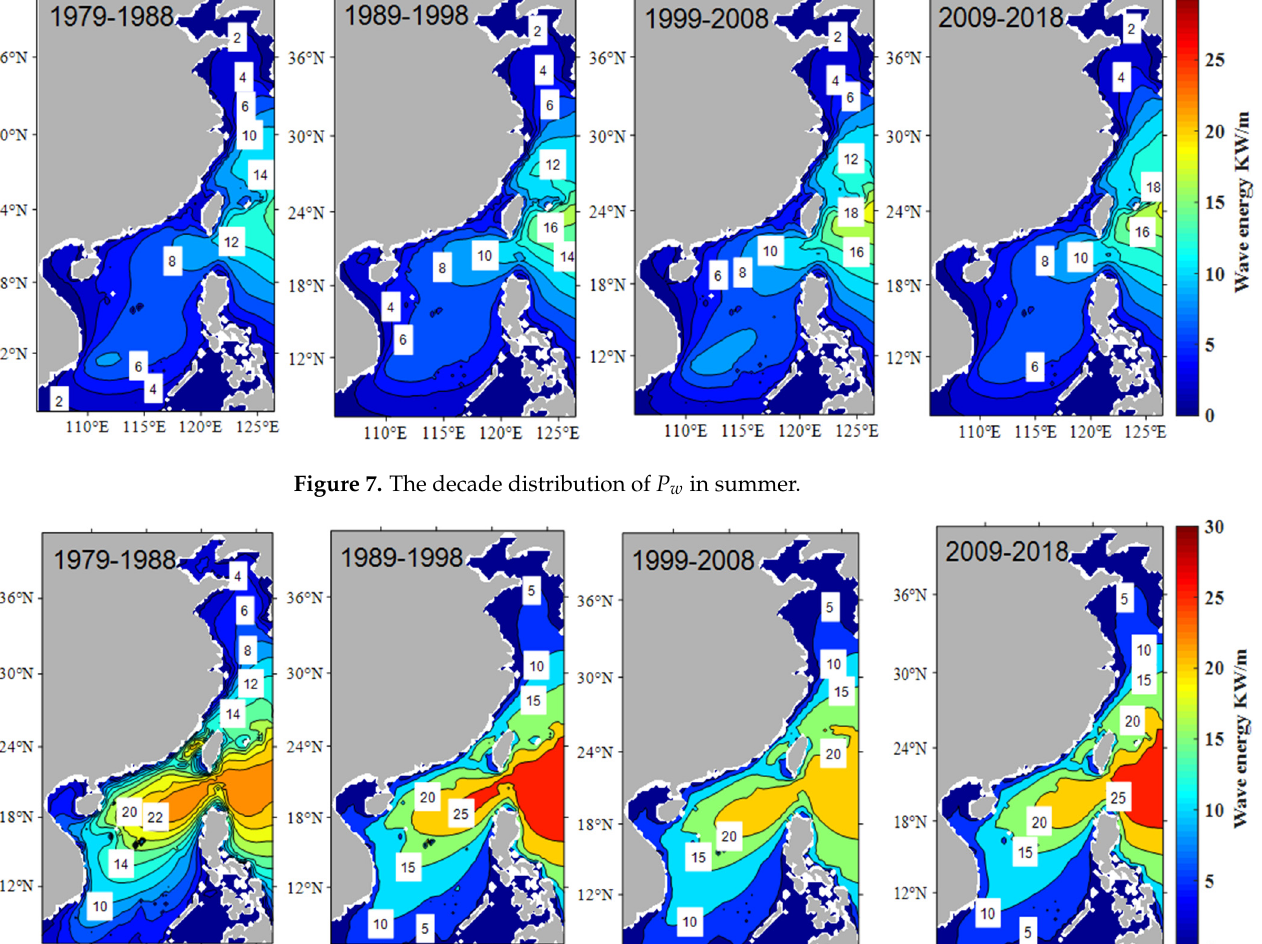
Figure 8. The decade distribution of P w in autumn.